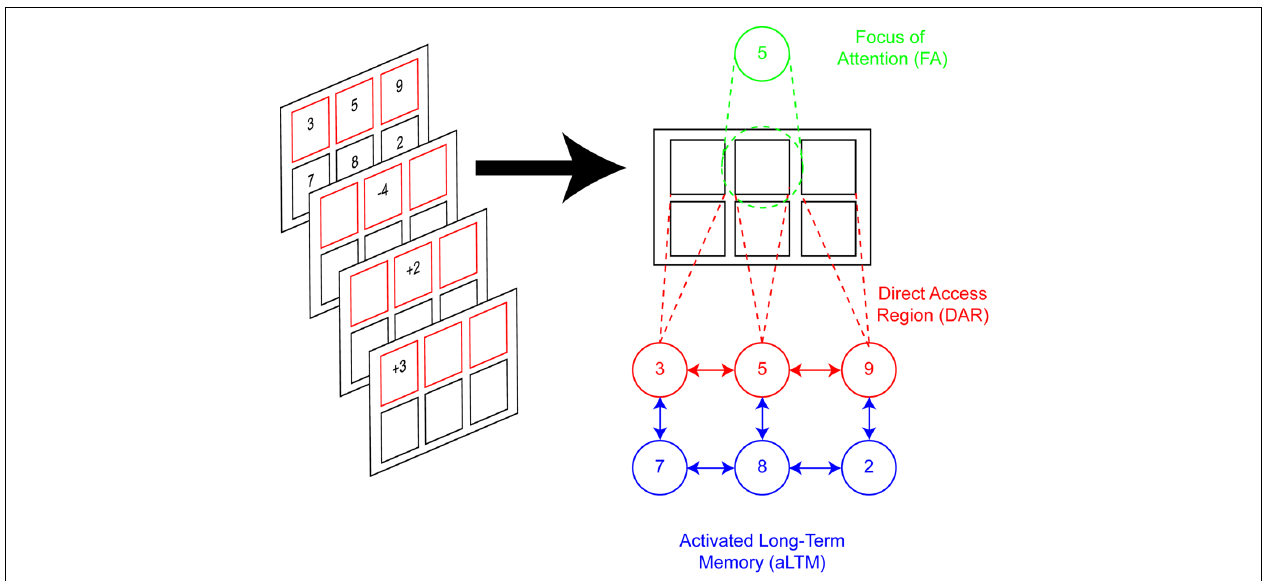
“8,” “2.” Right: depiction of the representational states of STM according to the model. The modeled scenario reflects the moment at which “ − 4” is presented. The cue “ − 4” draws the focus of attention (FA) to its corresponding frame. The number associated with that frame, “5,” is recalled through location-digit bindings. All location-digit bindings for the active set are maintained through the direct-access region (DAR). It is assumed that items are also inter-associated with each other, as well as other items that are not actively maintained (e.g., passive set). The passive set, which is not contextually bound, is held in activated long-term memory